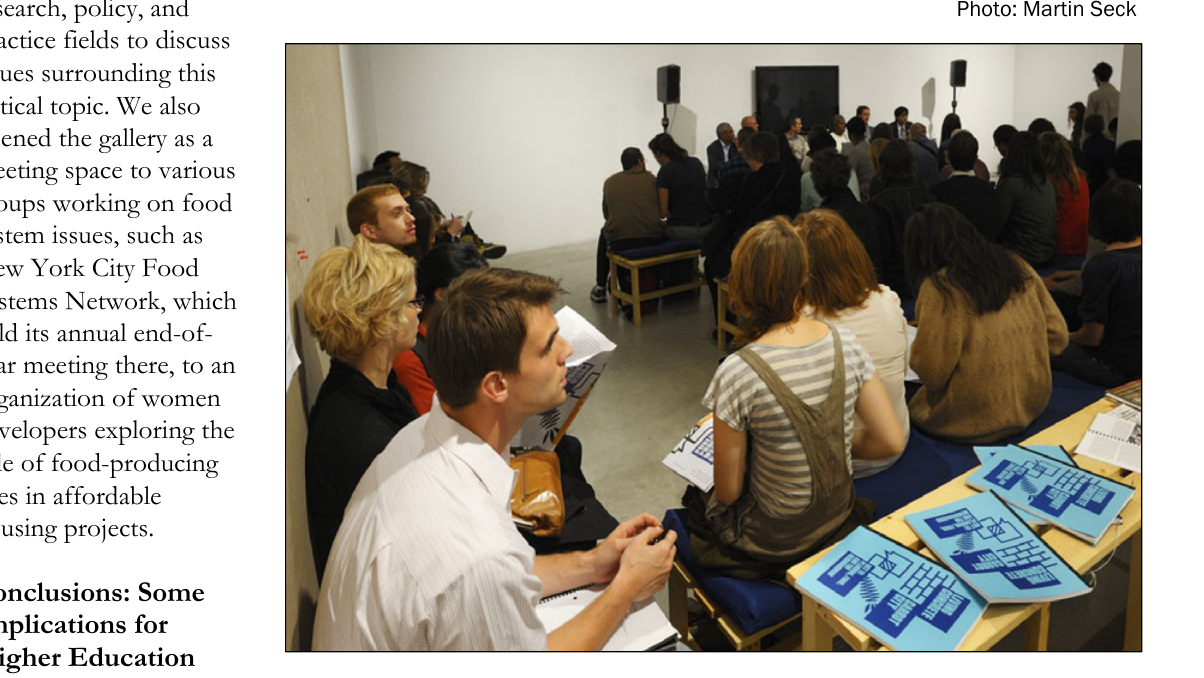
Figure 8. Panel Discussion on Food, Design, and Social